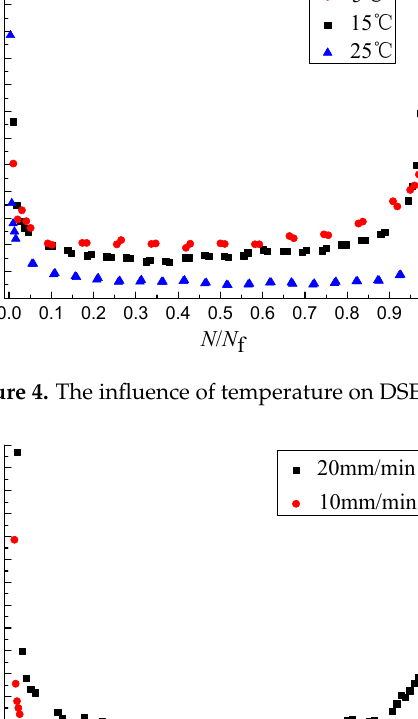
Figure 3. The influence of SSR on dissipated strain energy (DSE).